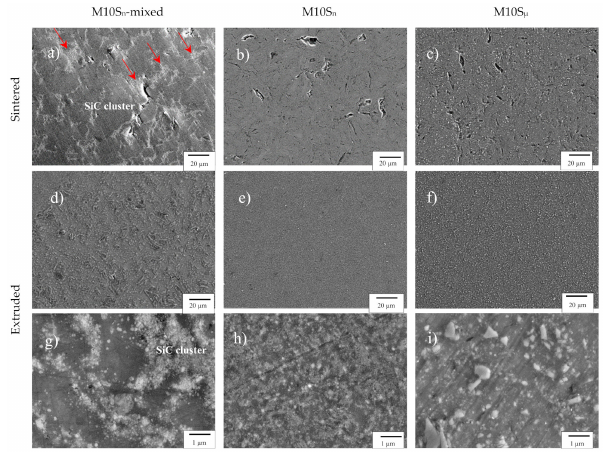
Figure 1. SEM micrographs of sintered ( a – c ), low ( d – f ), and high ( g – i ) magnification of hot extruded M10S n -mixed, M10S n , and M10S µ